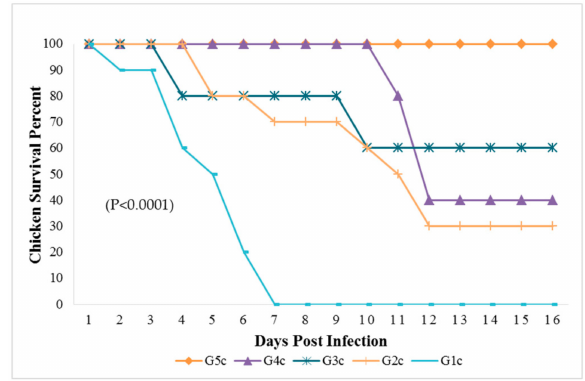
Figure 1. Survival percent in chicken groups until the 16th dpi analyzed by Chi-square test using statistical analysis system; SAS data frequencies were significant at ( p < 0.0001). G1c: n = 10, G2c: n = 10, G3c: n = 5, G4c: n = 5, and G5c: n = 10.